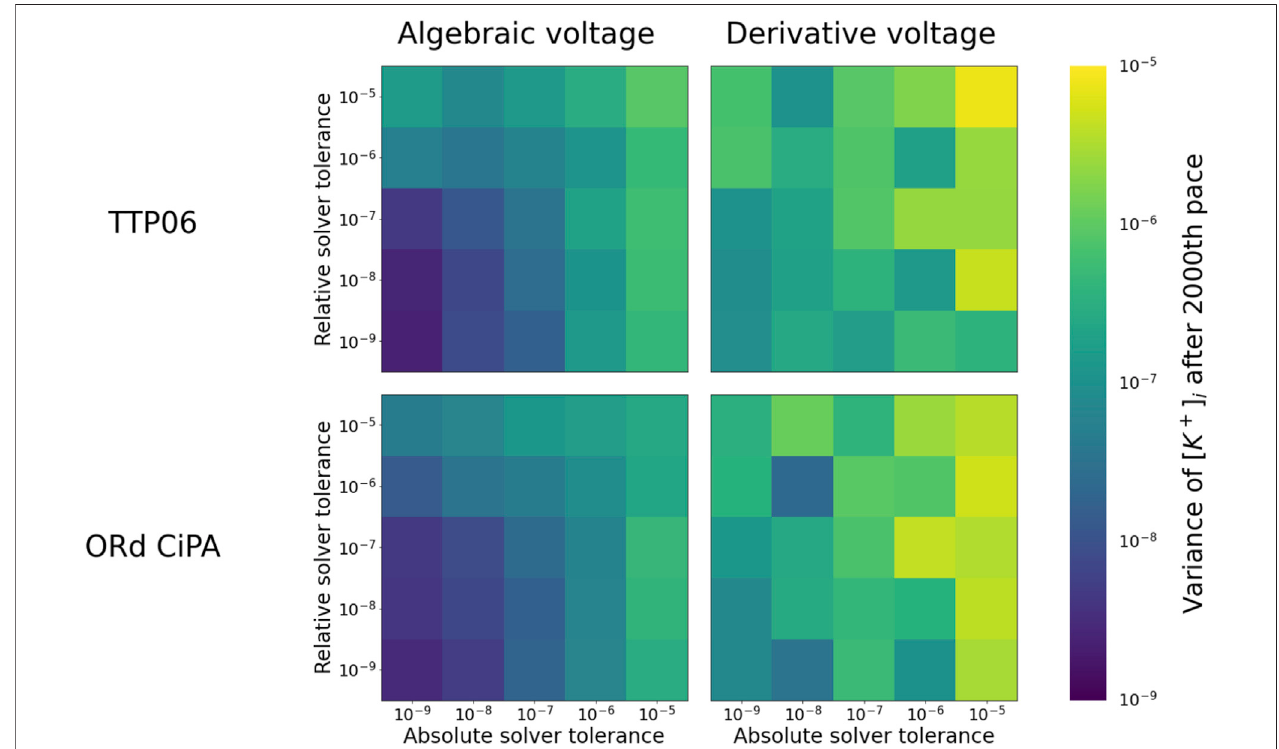
FIGURE3| Numerical stabilityof [ K + ] i intheTTP06 and ORd-CiPA models, comparing thederivative andalgebraic- V m forms. Thecolourmap corresponds tothe standard deviation of [ K + ] i between the 2000th and 3000th pace. The darker the map, the lower the variance, and the more stable the simulation.